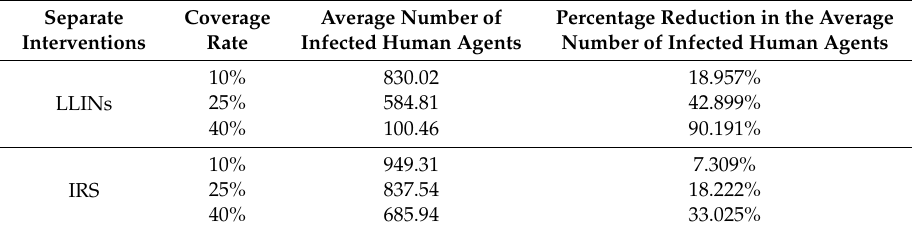
Table 4. Results of applying interventions of LLINs and IRS